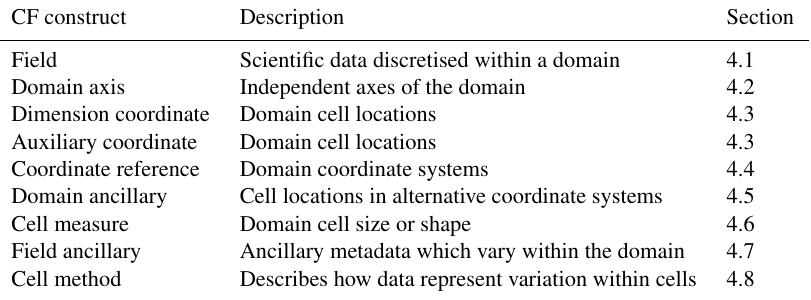
Table 3. The constructs of our CF data model, a brief description of each, and the section in which it is described in more detail. The relationships between the constructs and CF-netCDF elements are shown in Figs.